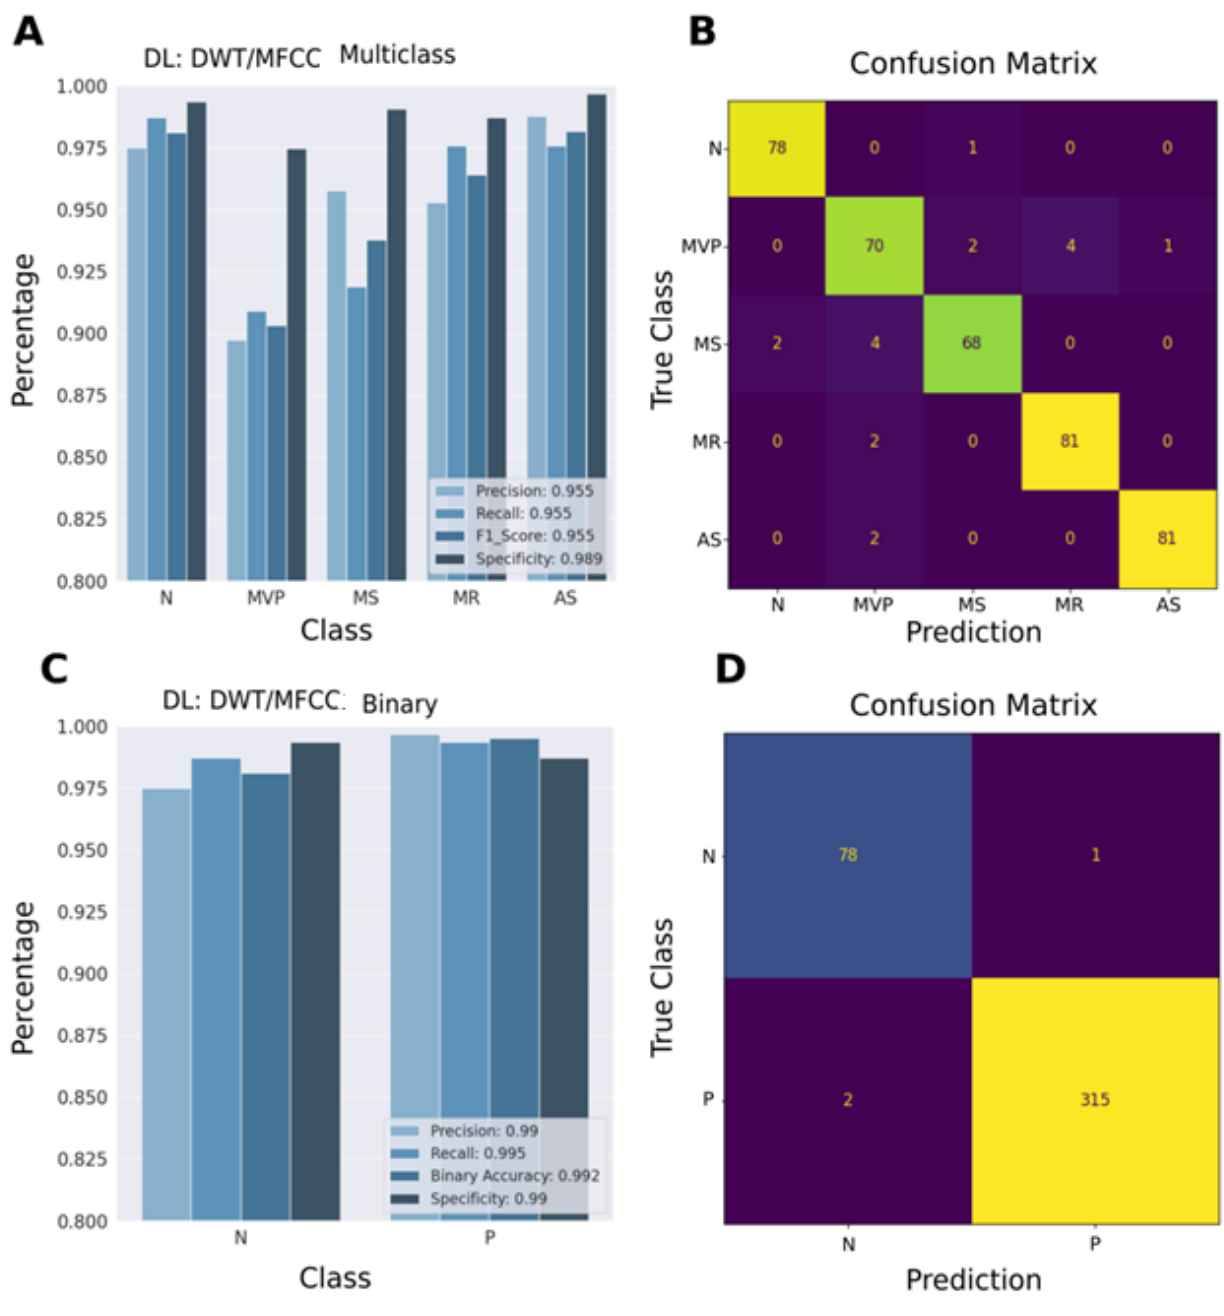
Figure 10. 20% of the dataset was used as the test set for deep learning (Precision, recall, F1 score, and specificity) of the full model in both classification techniques. To make the findings easier to see, only the percentages from 0.8 to 1.0 are displayed on the vertical axis, as shown in ( A ) and ( C ). Confusion matrices for binary and multiclass classification are shown in ( B ) and ( D ), respectively.